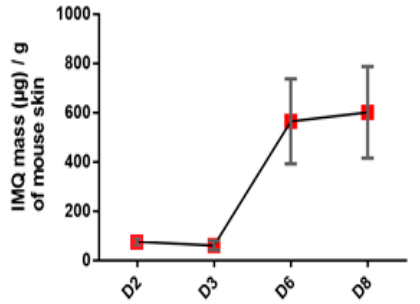
Figure 1. Evaluation of IMQ concentration in mouse skin in the course of IMQ-induced psoriasis-like dermatitis. Values are presented as mean ± SD.